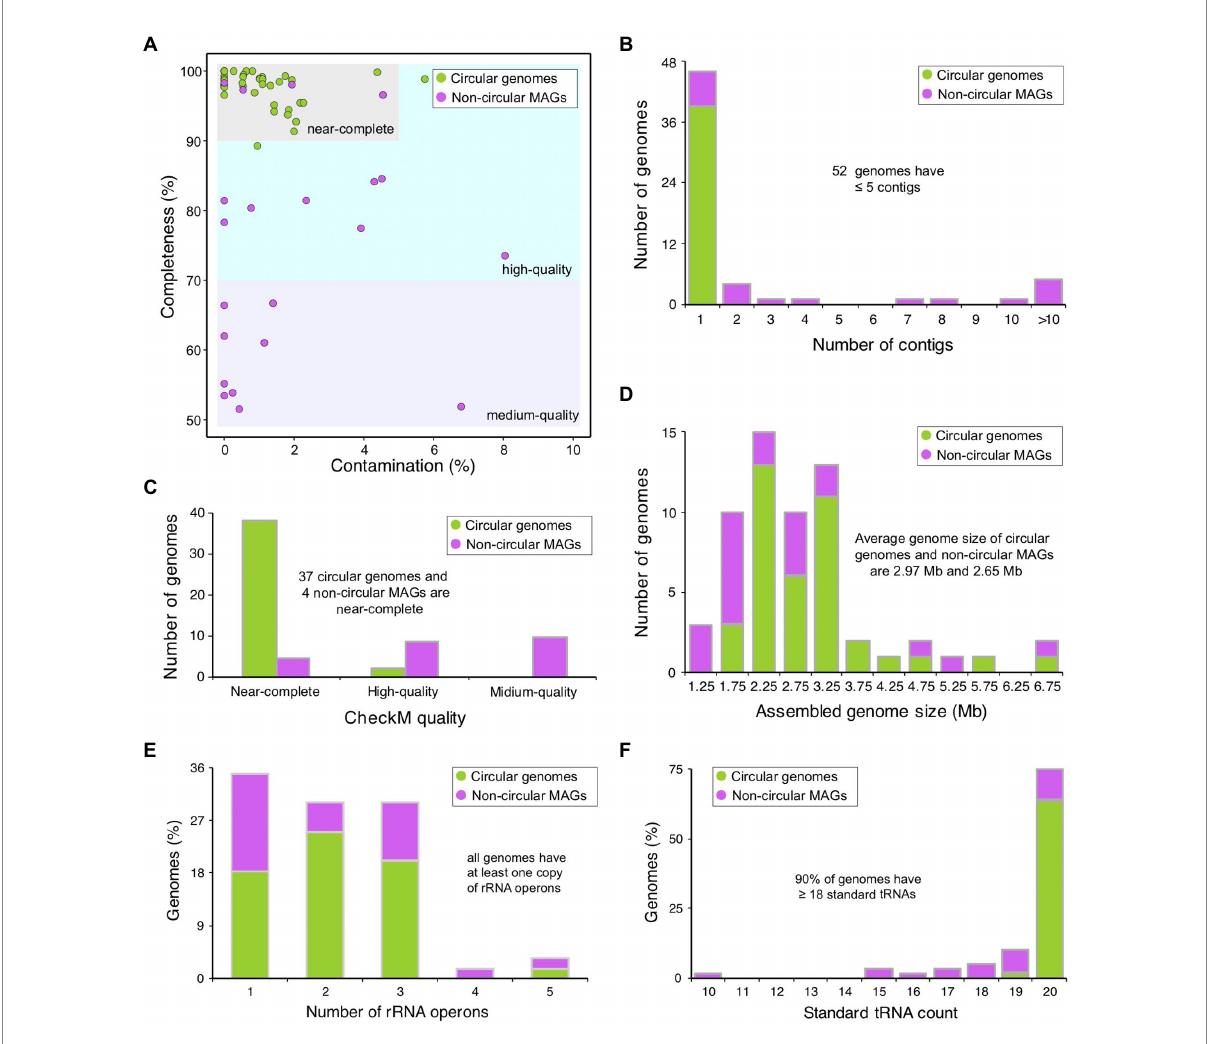
FIGURE 2 Statistics and evaluation of assembled microbial genomes. (A) CheckM evaluation of assembled microbial genomes. Circular genomes refer to circular contigs, and non-circular MAGs refer to genome assemblies derived from binning algorithms. Genomes are defined as “near-complete,” if their CheckM completeness values are ≥ 90% and contamination values are <5%, “high-quality” if completeness ≥ 70% and contamination <10%, or “medium-quality” if completeness ≥ 50% and contamination <10%. (B–D) Distribution of contig numbers, CheckM quality values, and genome sizes of assembled microbial genomes. (E,F) Distribution of the number of rRNA operons and standard tRNA genes for assembled